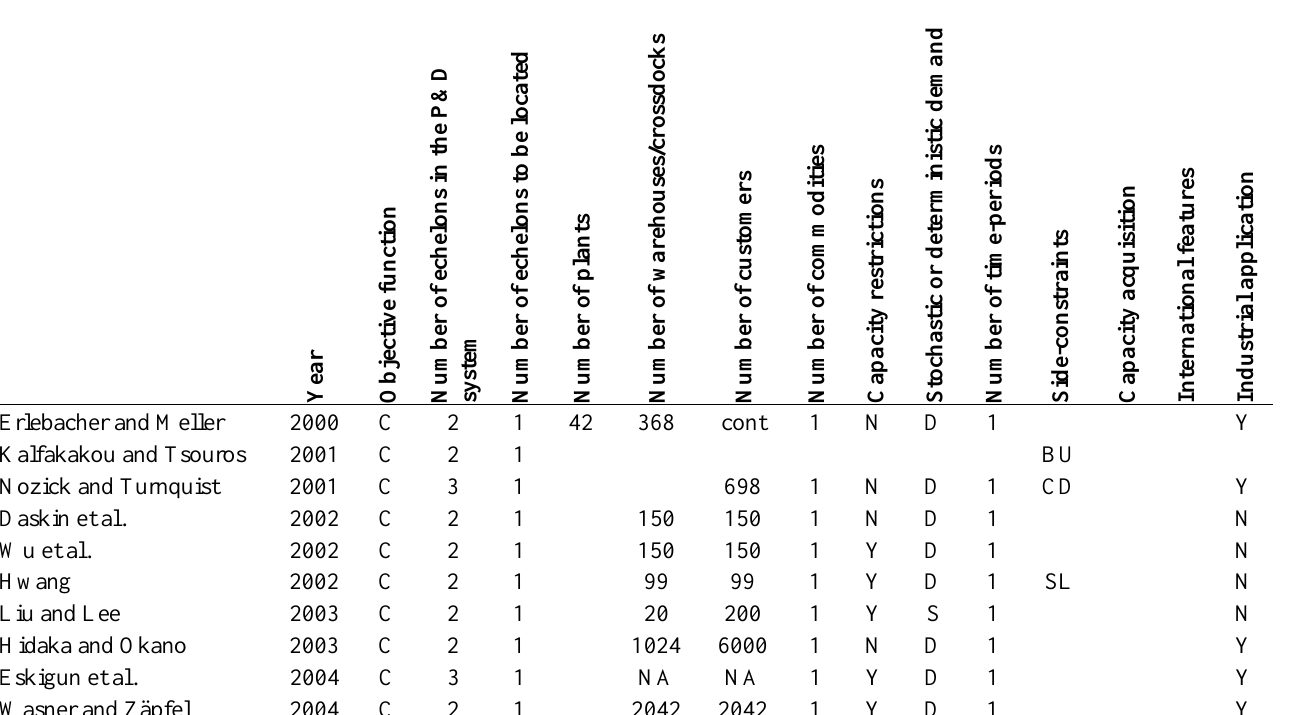
Table 2. Distribution facility